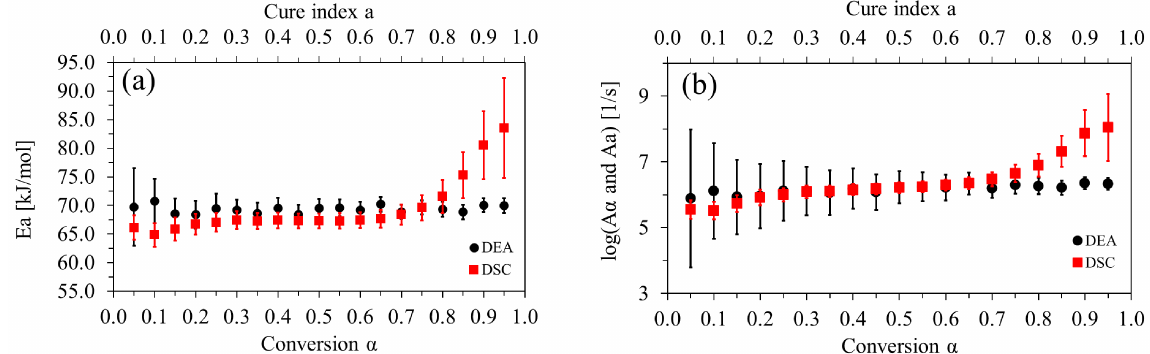
Figure 10. DEA and DSC: Comparison of the apparent activation energies ( a ) and apparent pre-exponential factors ( b ) determined via isoconversional methods of DEA (black dots) and DSC (red squares) with the corresponding standard errors.